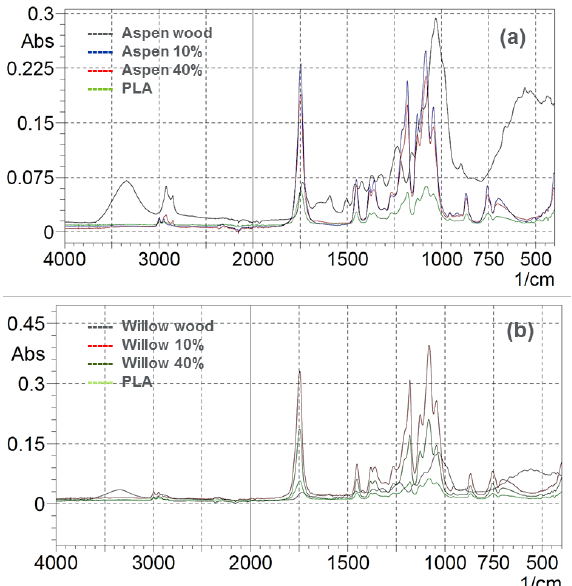
Figure 8. Fourier transform infrared spectrophotometer (FTIR) of wood particles, biopolymer and the biocomposites.